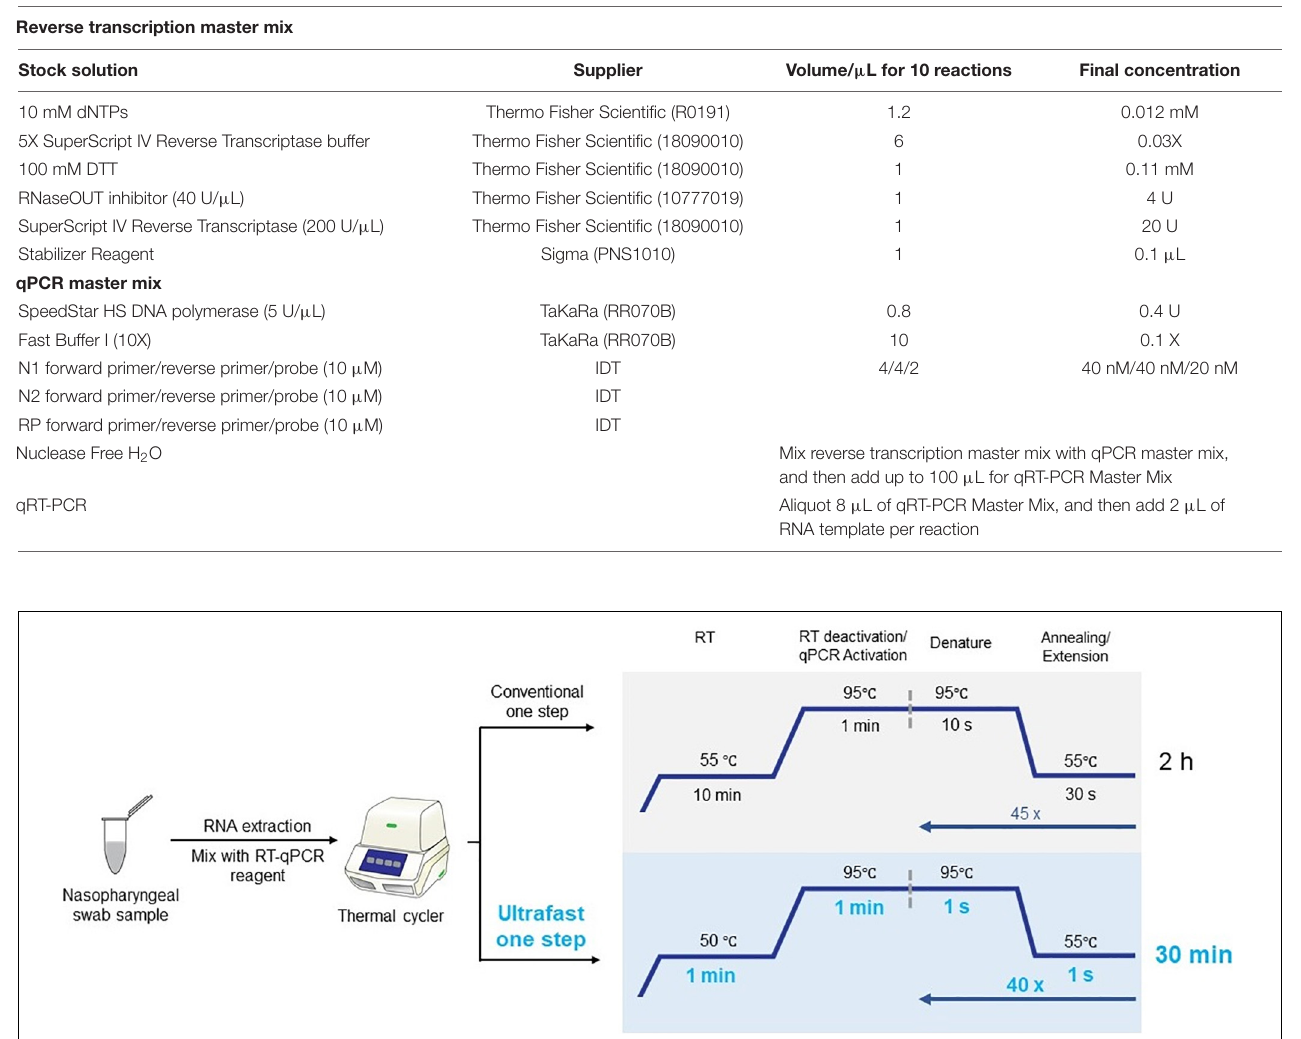
TABLE 2 | Components of the ultrafast one-step qRT-PCR master mix.